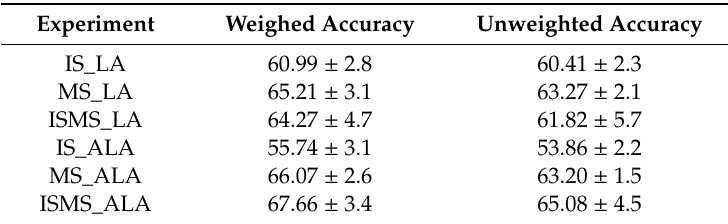
Table 3. Experimental results in the form of mean accuracies ± standard deviations.